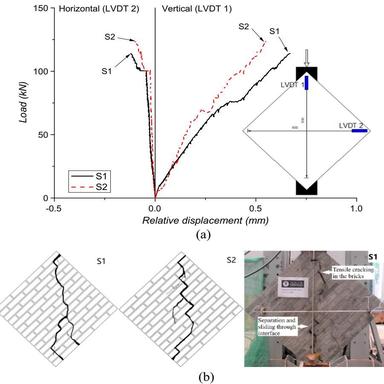
Experimental result of for masonry panel under shear (a) load–displacement response, (b) crack patterns.